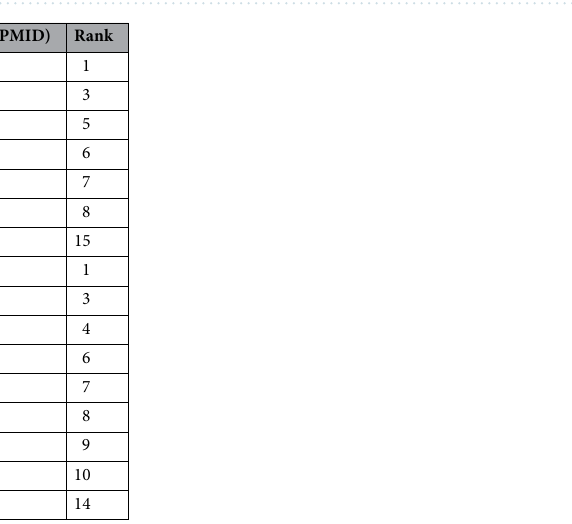
Figure 3. ROC was calculated by lncRNA projection, disease projection and proportional fusion and transformation curve of parameter in the range of [0,1].